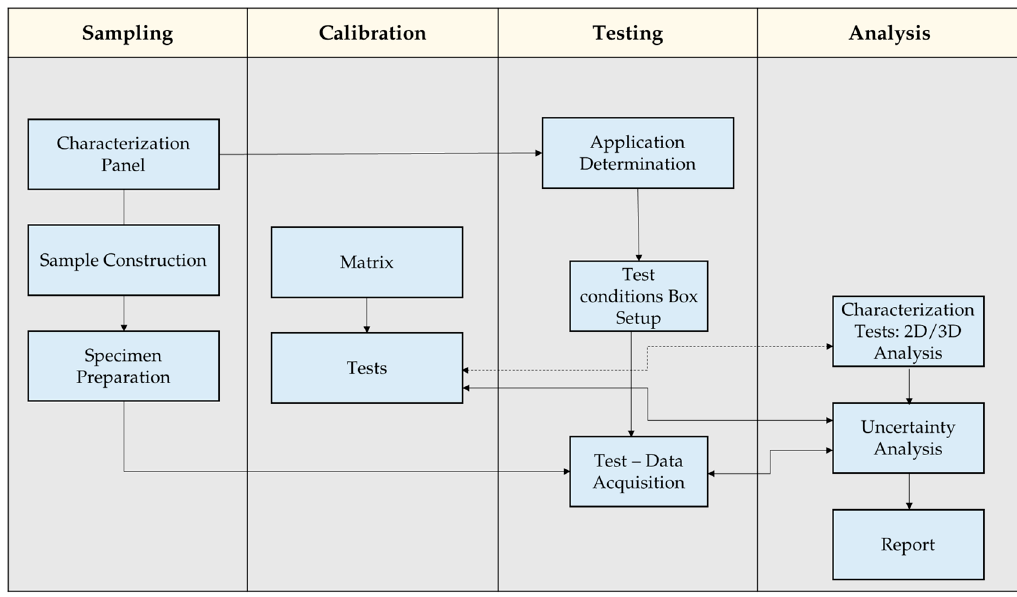
Figure 4. Block diagram of the research framework of the study.